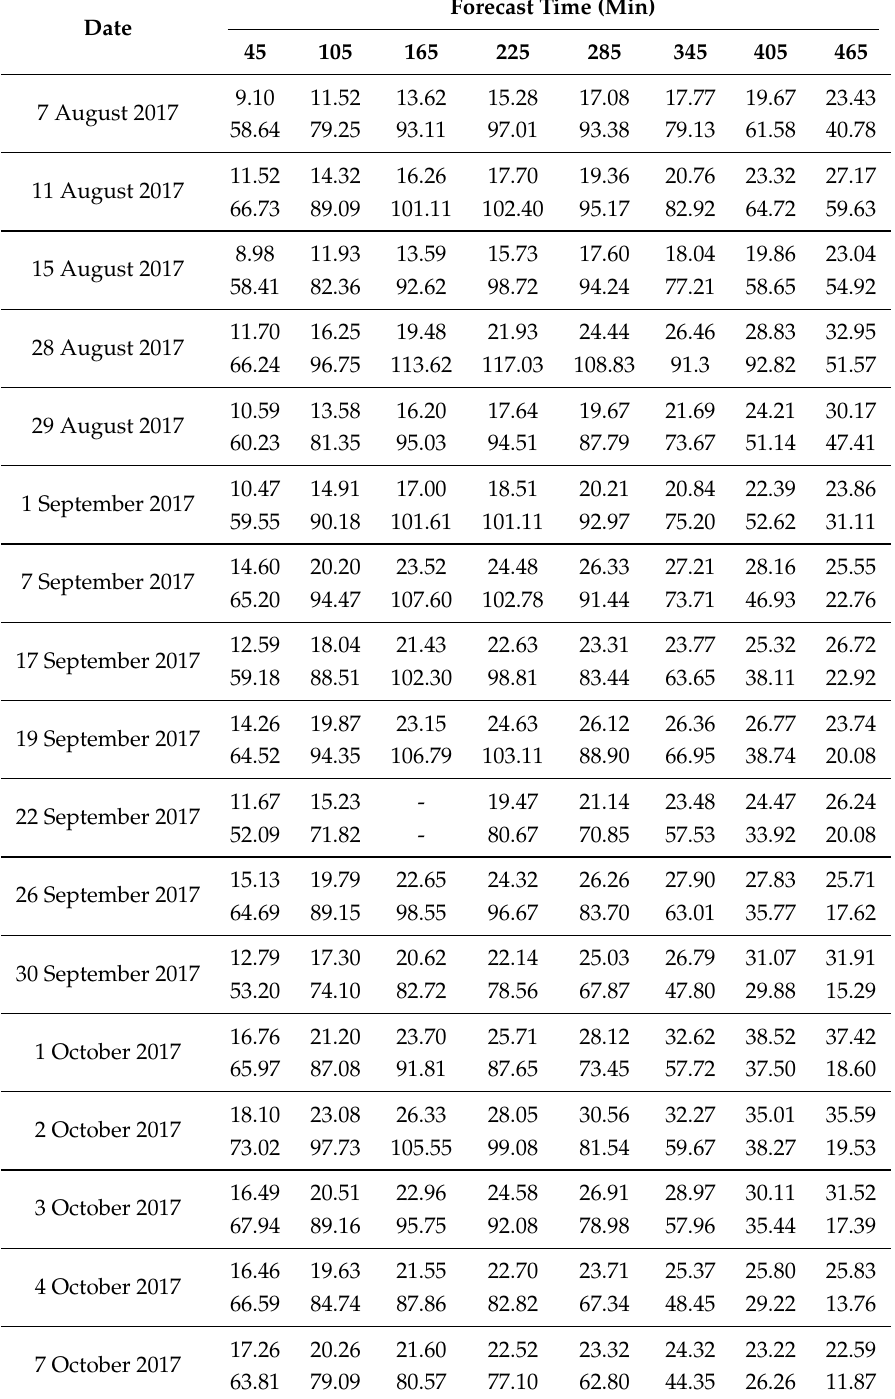
Table A3. Error measures of SARAH-2 validation for all cases up to 465 min of forecast time. These values were calculated for the area of Europe. The upper row of each date represents the relative absolute bias in % and the lower one shows the absolute bias in W/m 2